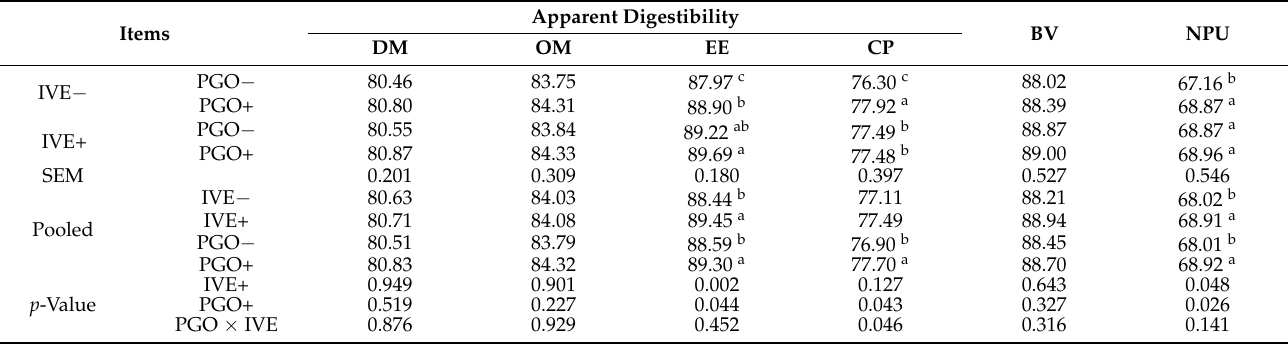
Table 3. Effect of probiotics with added glucose oxidase (PGO) and Illicium verum extracts (IVE) on the nutrient digestibility of weaned piglets 1 , %.